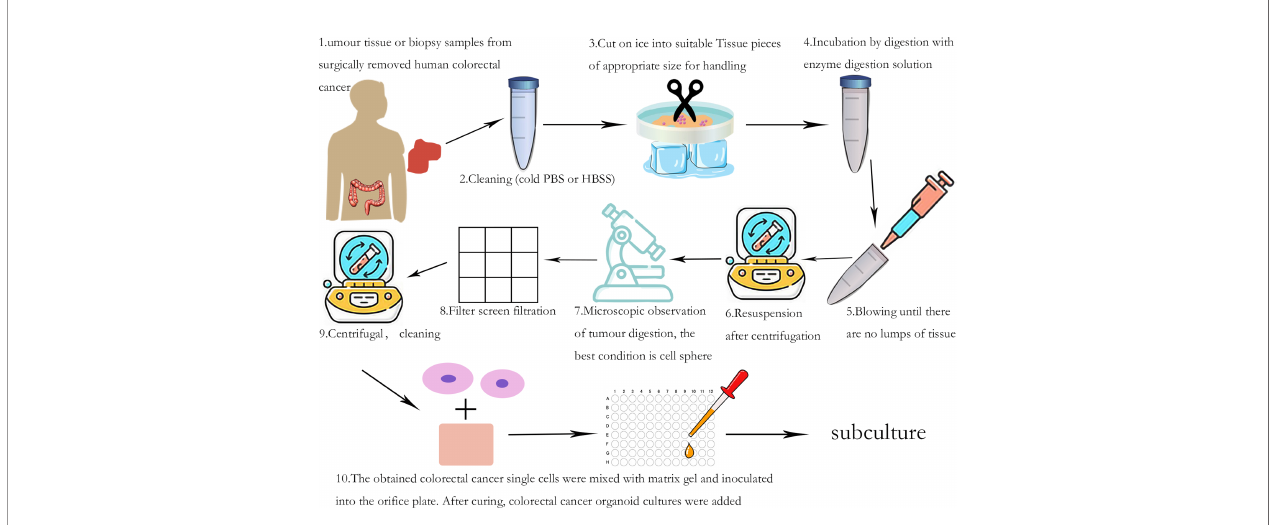
FIGURE 2 | Cultivation process of